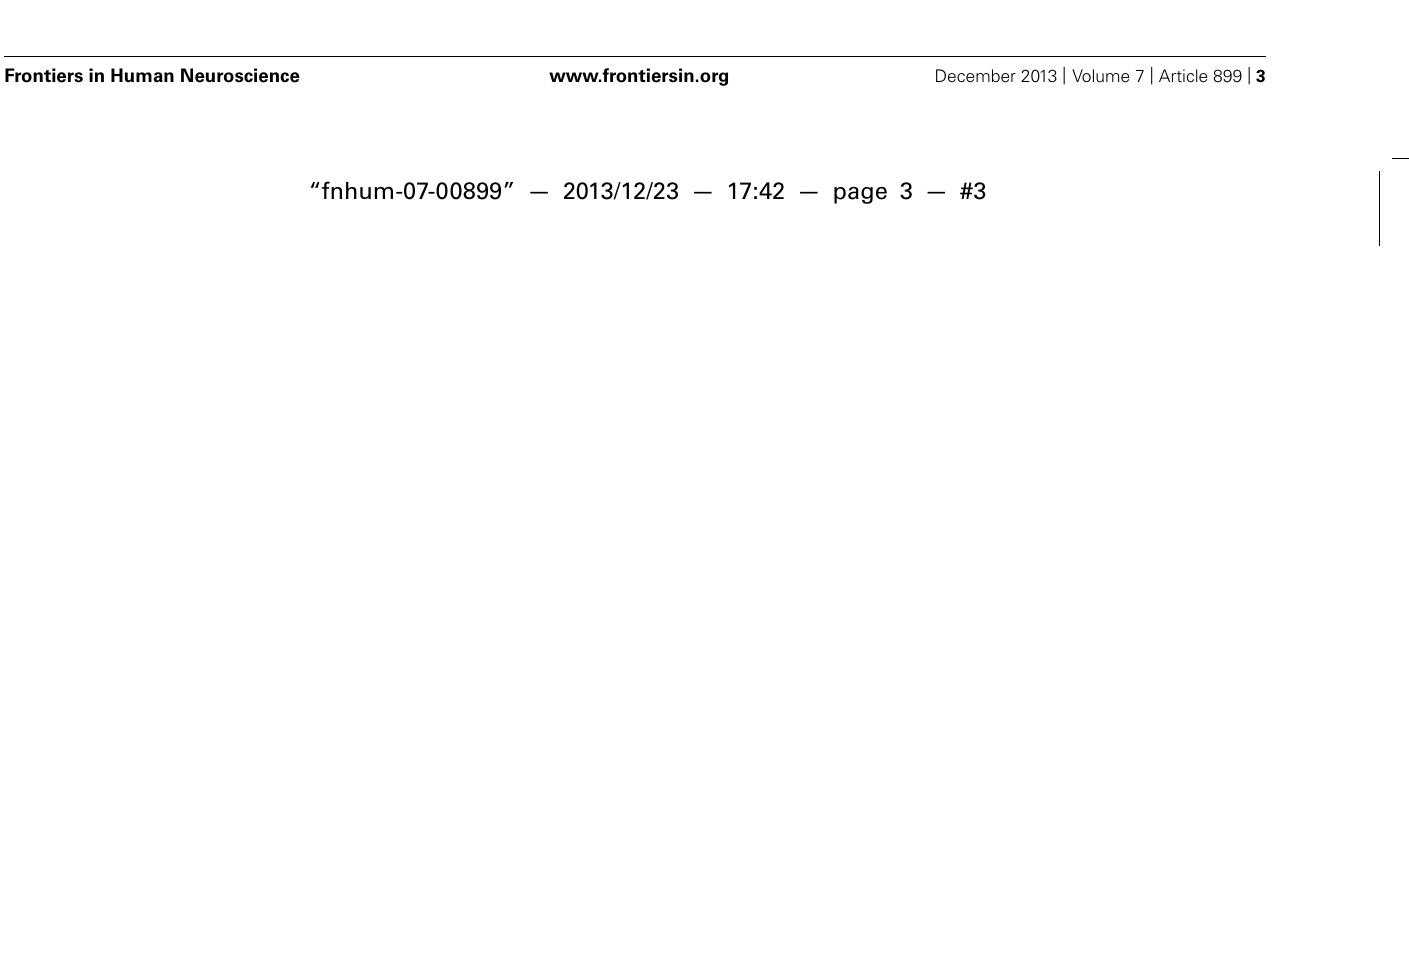
FIGURE 1 | (A) Schematic illustrating formant information for the [ba] and [ga] stimuli.The F 0 , F 1 , and F 3 are identical.The stimuli differ in F 2 onset frequencies with [ba] (blue) ascending and [ga] (green) descending to stabilize for the vowel portion. (B) Schematic illustrating the expected phase